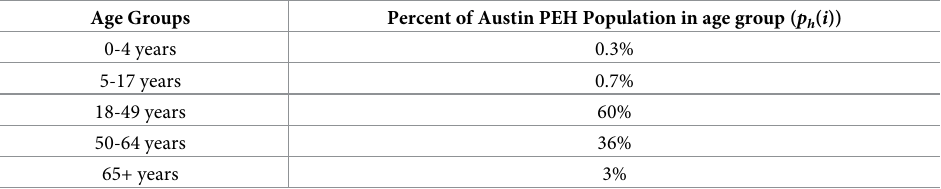
Table 1. Estimated age distribution of PEH in Austin, TX